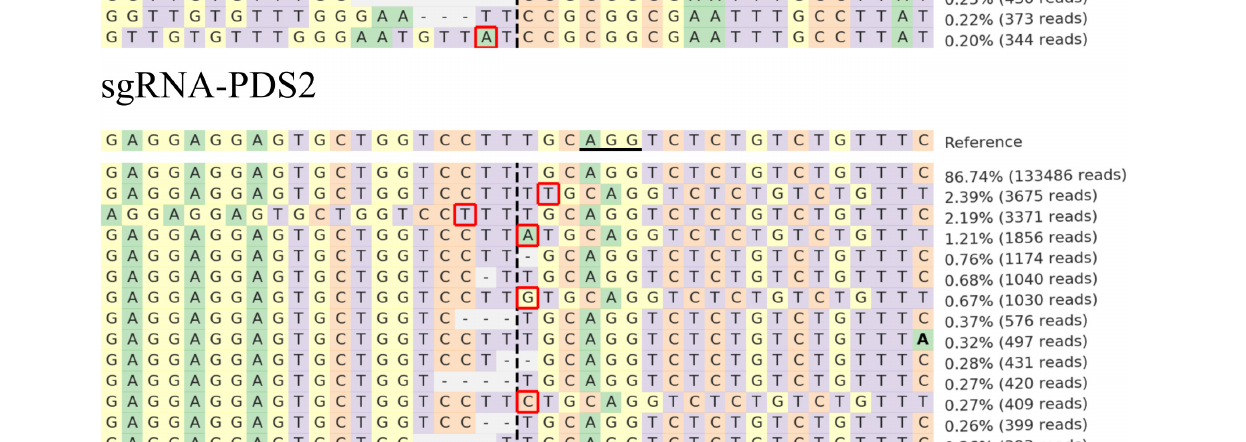
Frontiers in Plant Science |